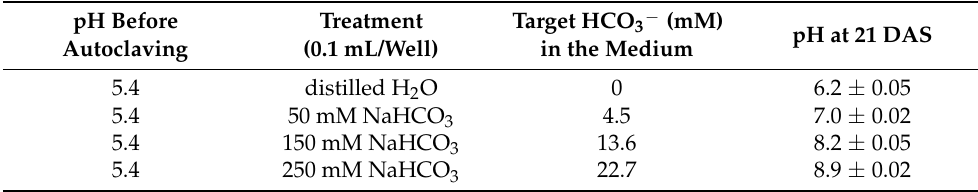
Table 2. Overview of the bicarbonate treatments in experiment 2 and medium pH 21 days after the start of the treatment (21 DAS). (Mean ± SE, n =